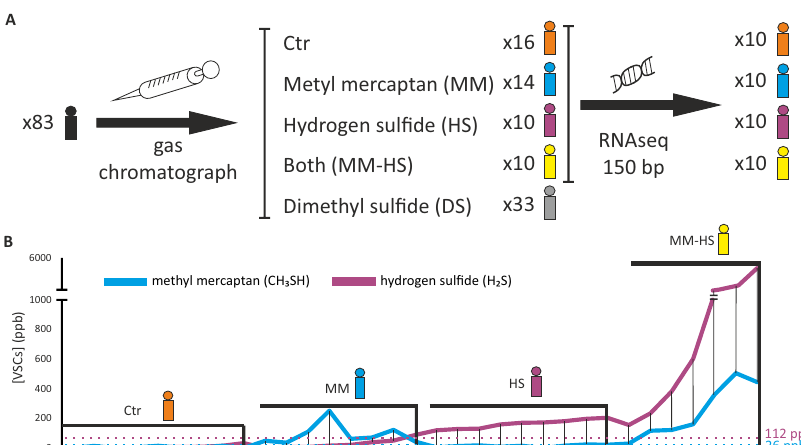
Fig. 1 Study design for the metatranscriptomic analysis of tongue coating in halitosis. A The concentrations of three Volatile Sulfur Compounds (VSCs) in breath samples from 83 individuals was measured by gas chromatography and based on the levels of those gases, different groups were differentiated. Tongue bio fi lm samples were collected, and the extracted RNA was sequenced in 10 individuals per group. B The concentrations (ppb) of the two main intra-oral VSCs, methyl mercaptan and hydrogen sul fi de, are shown for the 40 individuals whose transcriptomic pro fi le was analyzed. The dotted lines indicate the consensus threshold concentration for halitosis.